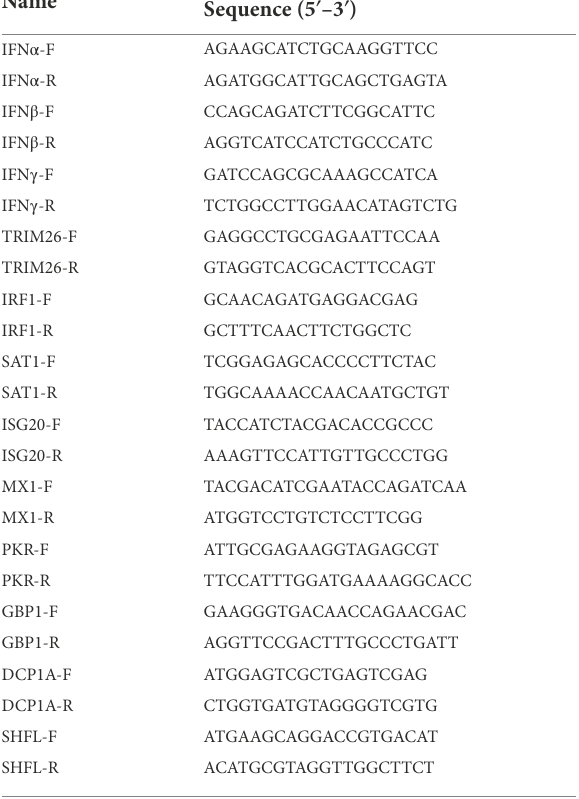
TABLE 3 The primers used for determining the mRNA level of 9 ISGs and IFNs by